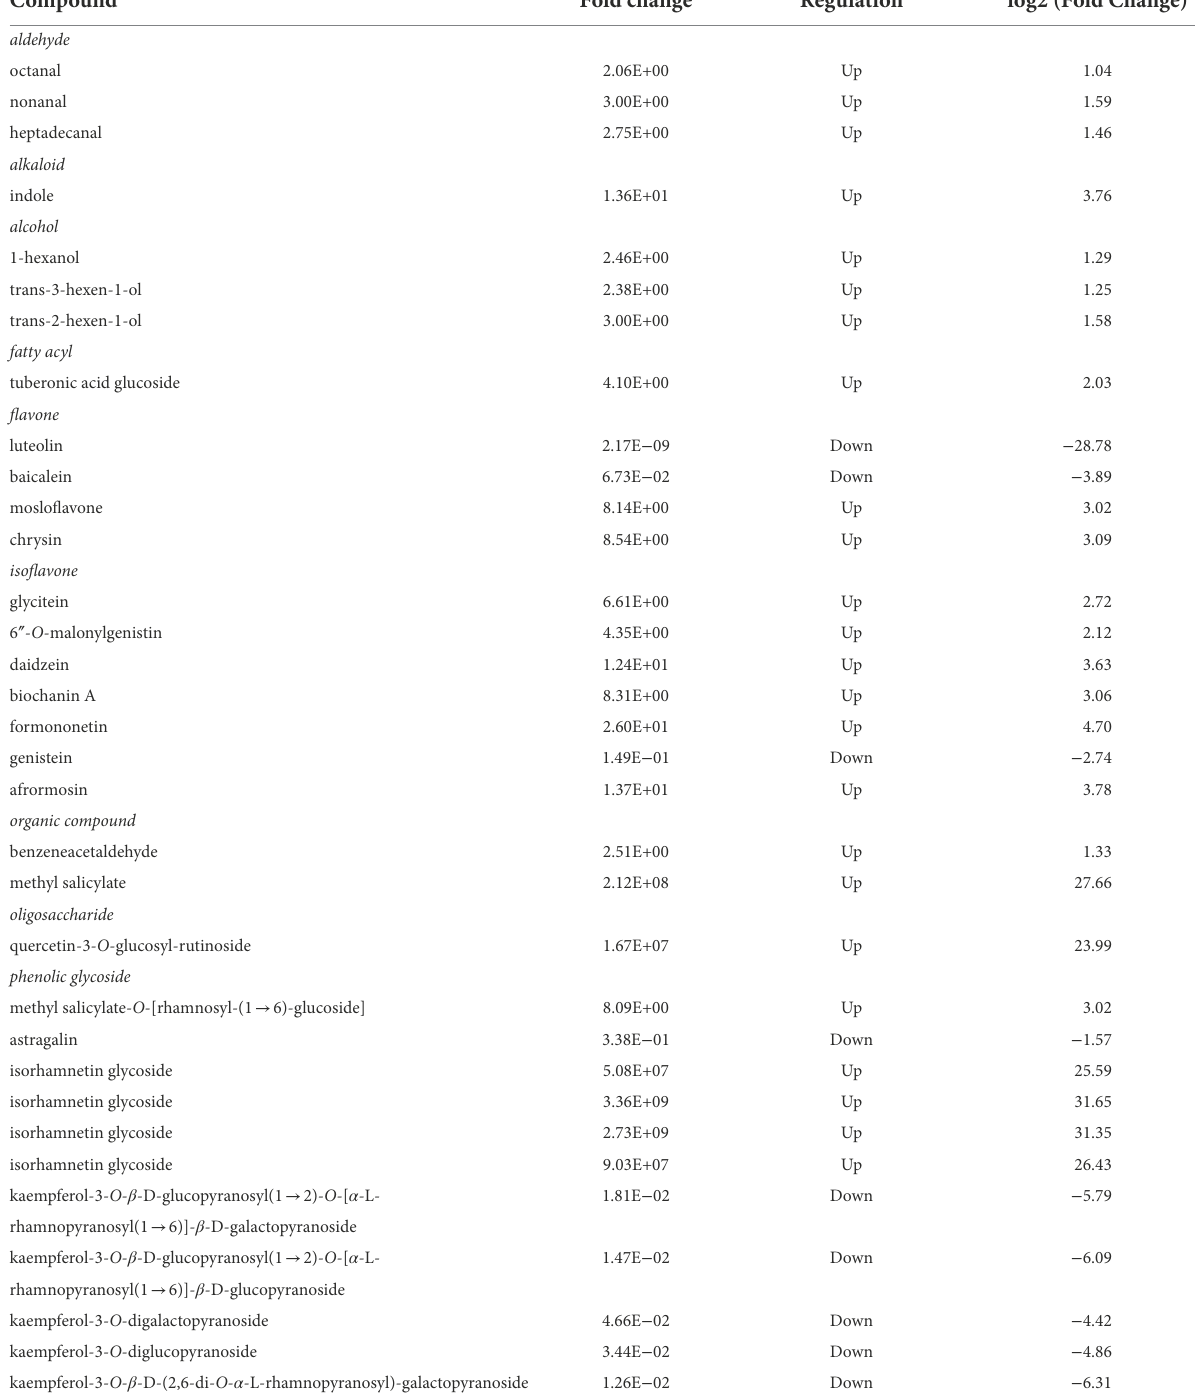
TABLE 4 Differentially expressed metabolites in the resistant cultivar with p < 0.05 for t -test and fold change ≥ 2 and relative abundances. Compound Fold change Regulation log2 (Fold